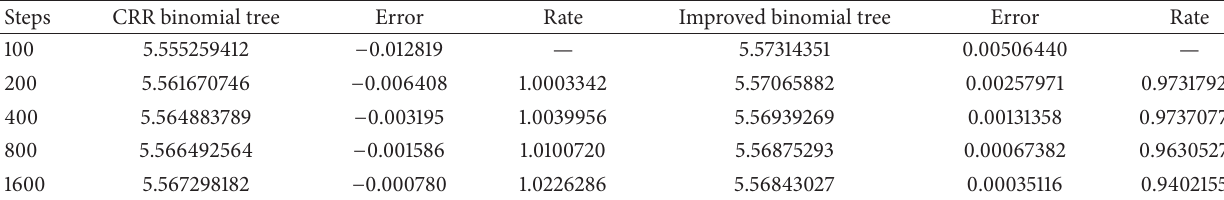
Table 2: Numerical results for Example 2.